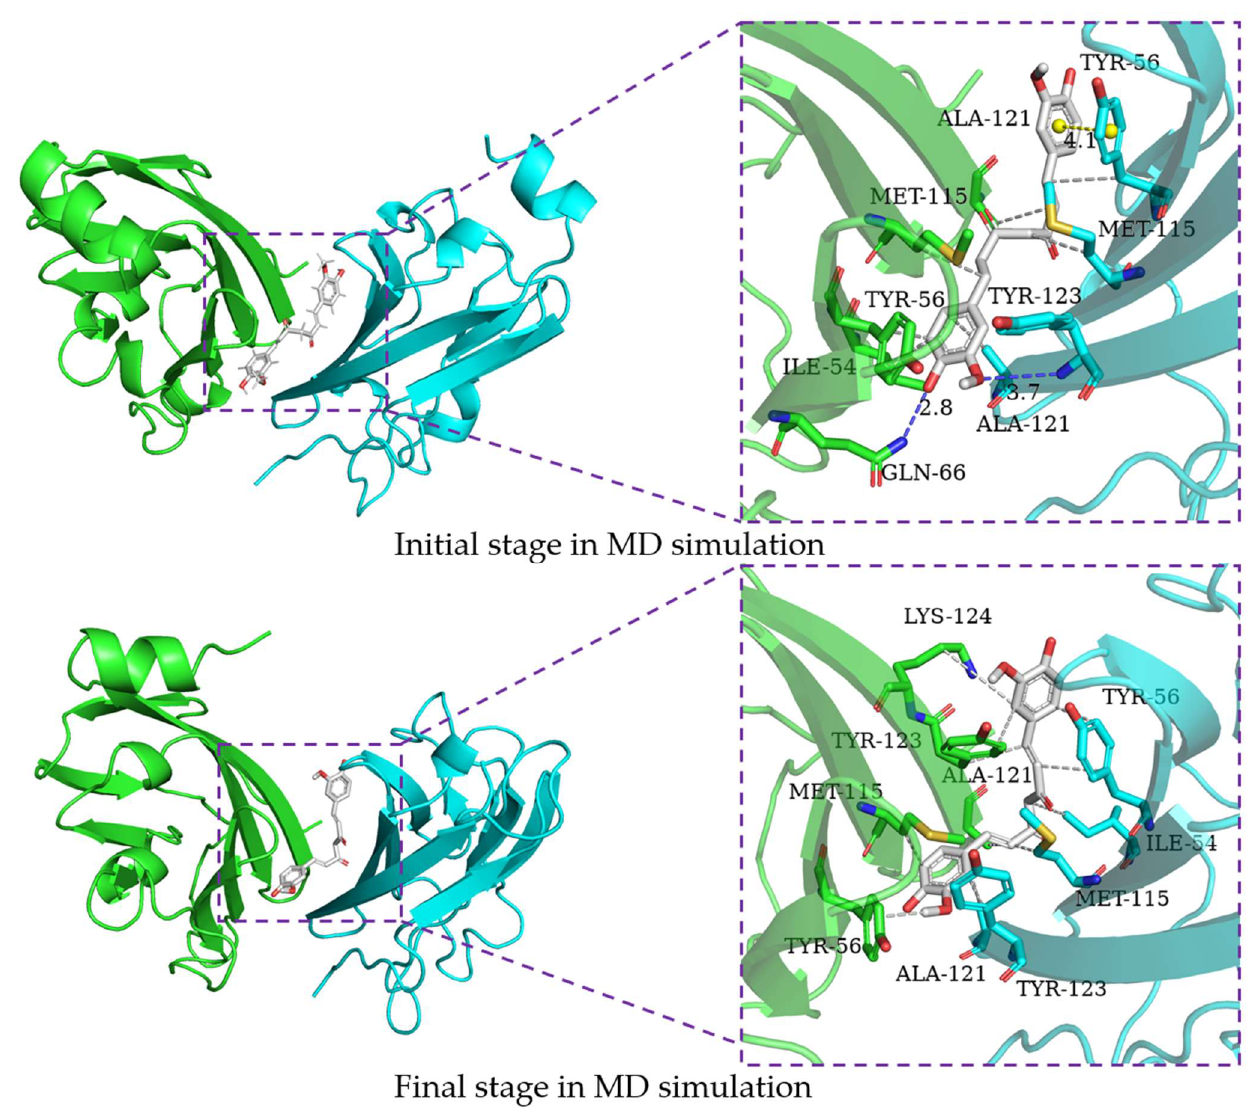
Figure 9. The interaction of curcumin and residues of binding site at 0 ns and 200 ns, the key residues on (A)PD-L1 and (B)PD-L1 are shown as green and cyan sticks, respectively, while the ligands are shown as white sticks. Hydrophobic interactions, H-bonds and Π-stacking are shown as gray, blue and yellow dashes, respectively. Table 7. The H-bonds occupancy of capsaicin, zucapsaicin, curcumin and 6-gingerol (-side is the sidechain of residue, -main is the mainchain of residue).